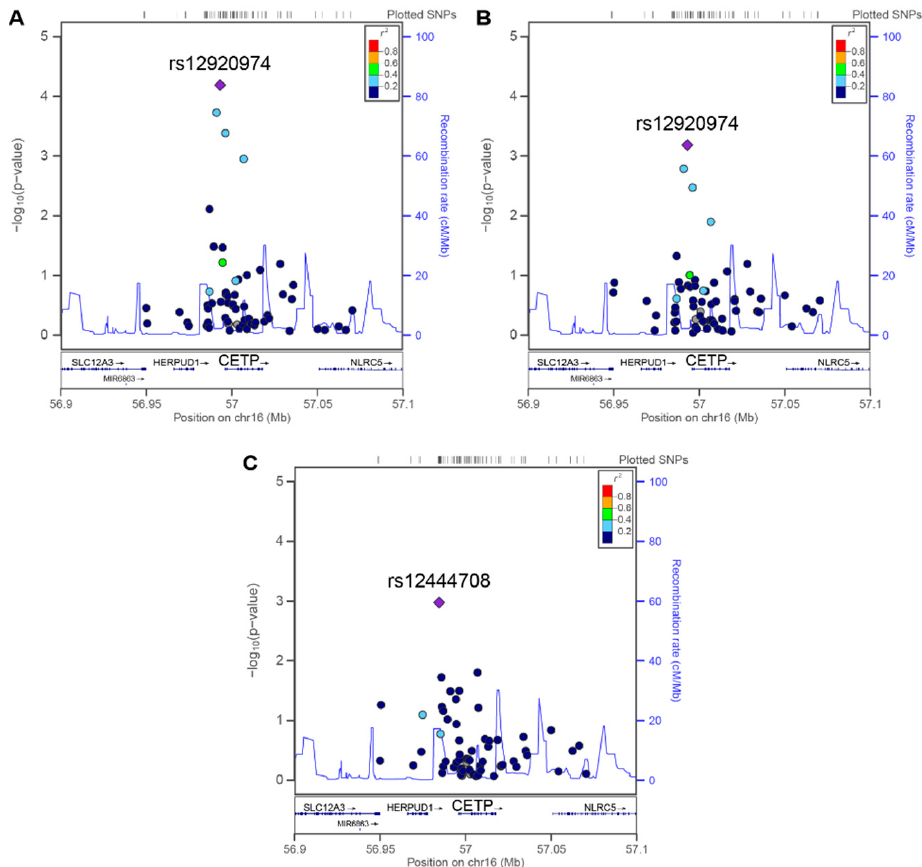
Figure 2. Regional plots of SNPs in the CETP region with evidence of an association with cIMT max . Each circle represents a single-nucleotide polymorphism (SNP) plotted with its association p -value (on a − log10 scale) as a function of genomic position. ( A ) Plot from the entire IMPROVE cohort. Plots for ( B ) the pooled 1st, 2nd, and 3rd quartiles and ( C ) the 4th quartile of HDL-C plasma concentration. For each association analysis, the lead SNP is represented by a purple diamond. The color of all other SNPs indicates the degree of linkage disequilibrium with the lead SNP (see r2 values on the right). Analyses were adjusted for age, sex, cholesterol, log-triglycerides, use of fibrate and/or fish oil and/or statins, and MDS1–3 (population substructure). Abbreviations are the same as those in Figure